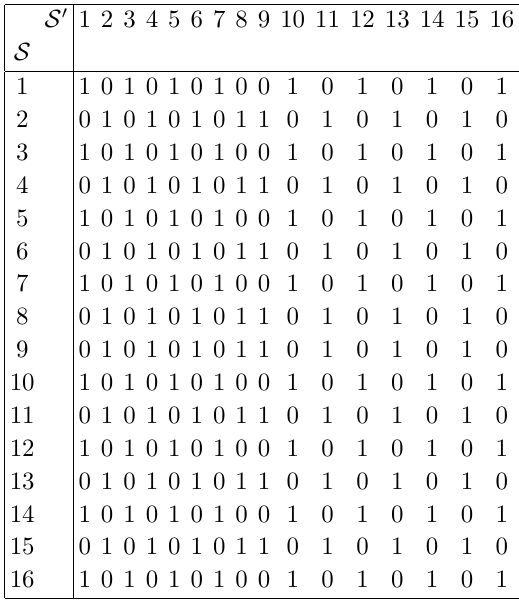
Table 21 . Gadget values for P